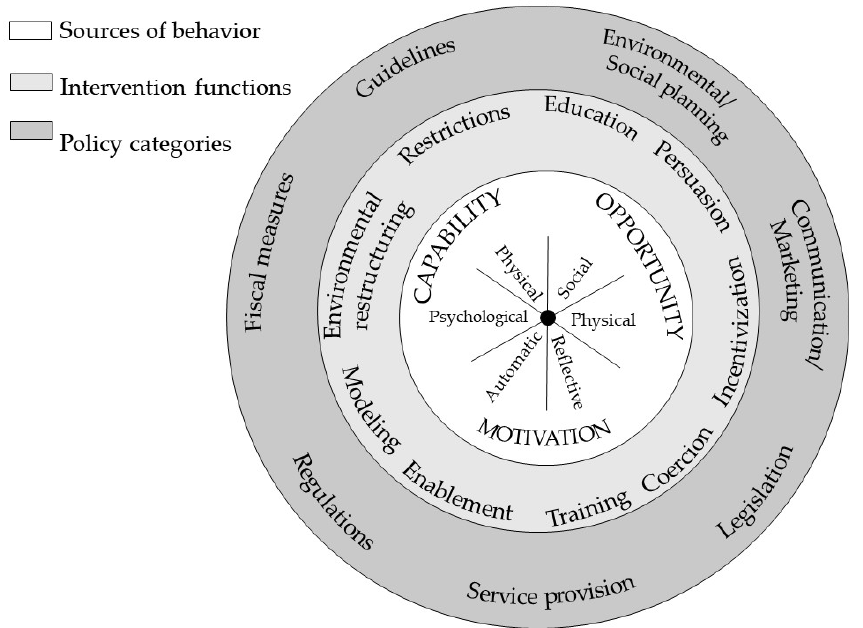
Figure 1. Behavior Change Wheel. Reproduced with permission from Michie S, Atkins L, West R. (2014) The Behavior Change Wheel: A Guide to Designing Interventions . London: Silverback Publishing. www.behaviourchangewheel.com, (accessed on 1 May 2022).